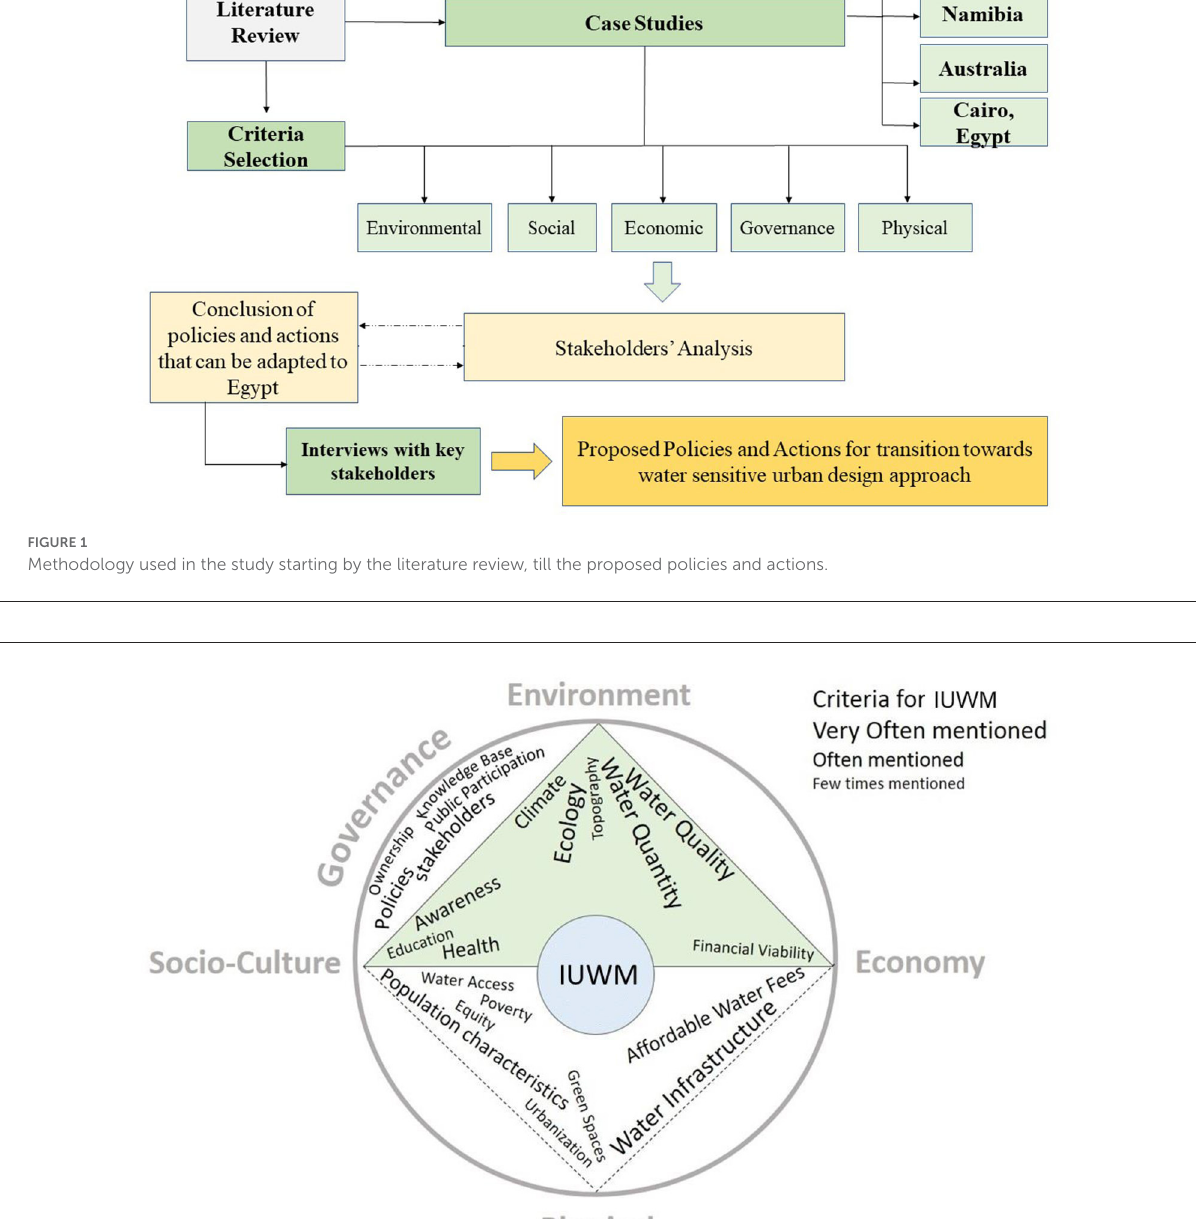
the relationship between the public and private sectors; and integrated policies to determine water demand management